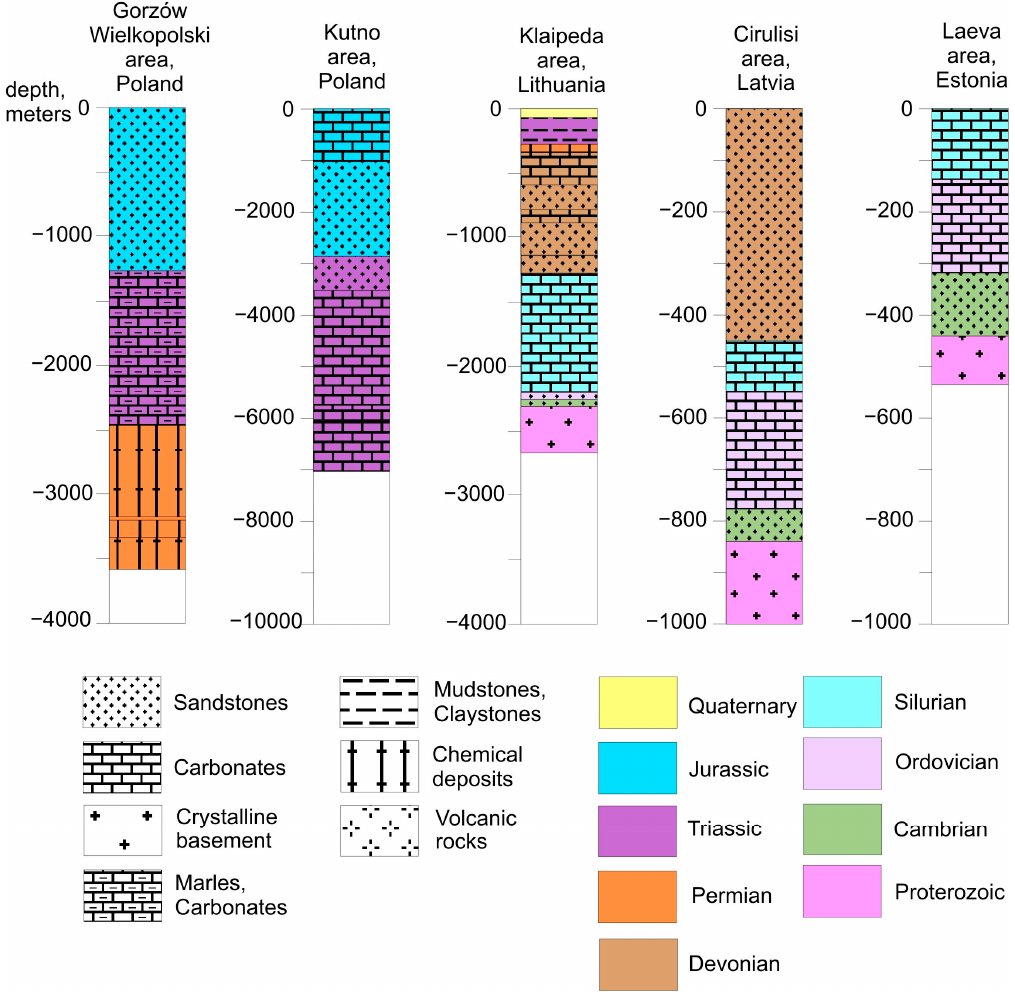
Figure 8. Simplified lithostratigraphic profiles of selected areas in Baltic countries. Based on [31,63,73–75] . Prospective hot dry granites and volcanites in Poland are deposited at a depth of about 4000 to 4300 m, which is a similar depth range as EGS installations in Groß Schönebeck and shallower than in Soultz-sous-Forêts. The temperature of the target zone, calculated from the geothermal gradient (35–40 °C/km), is comparable to the eastern Germany EGS sites (about 150 °C), and significantly exceeds the temperature in Espoo (Finland) ( Tables 1 and 2 ). The tight sedimentary formations of Poland in Mogilno-Łódź and Szczecin Troughs are located deeper (5000 m to over 6500 m) comparable to the crystalline basement target zone in Espoo and porphyric granites in Rhine Graben; however, they are warmer than the rock of Finland (much above 150 °C), and at the deepest parts reach predicted temperatures similar to those in Soultz-sous-Forêts (up to 195 °C).